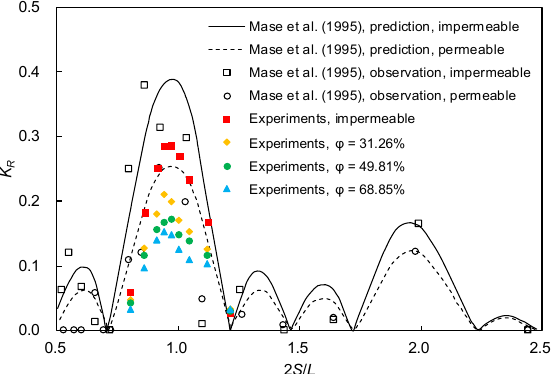
Figure 10. Comparison of experimental values of porous bars on the horizontal seabed (Mase et al. [36]).